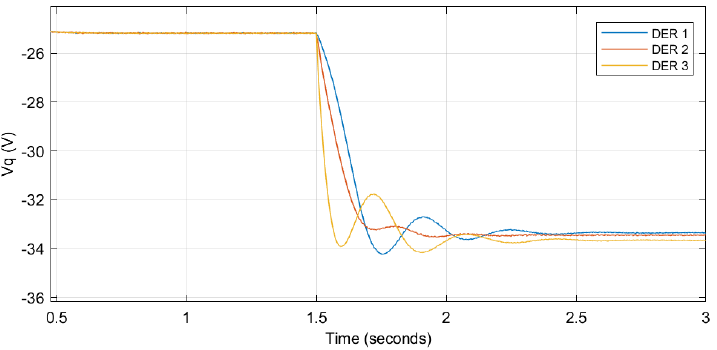
Figure 6. v dpq drop in voltage due to typical virtual impedance.